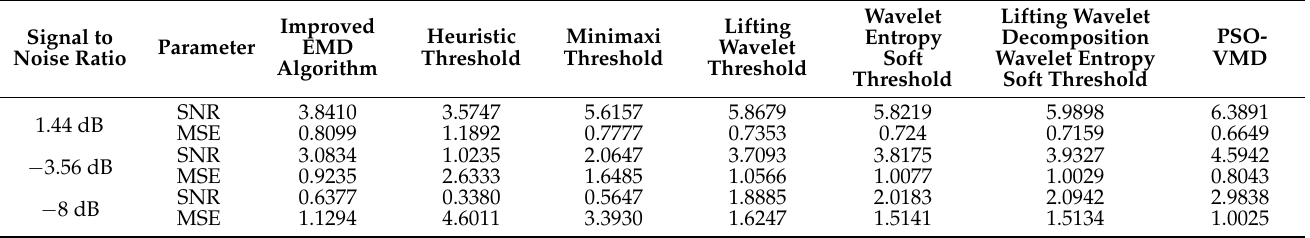
Table 5. Comparison of denoising effects compared with the PSO-VMD algorithm under differ- ent